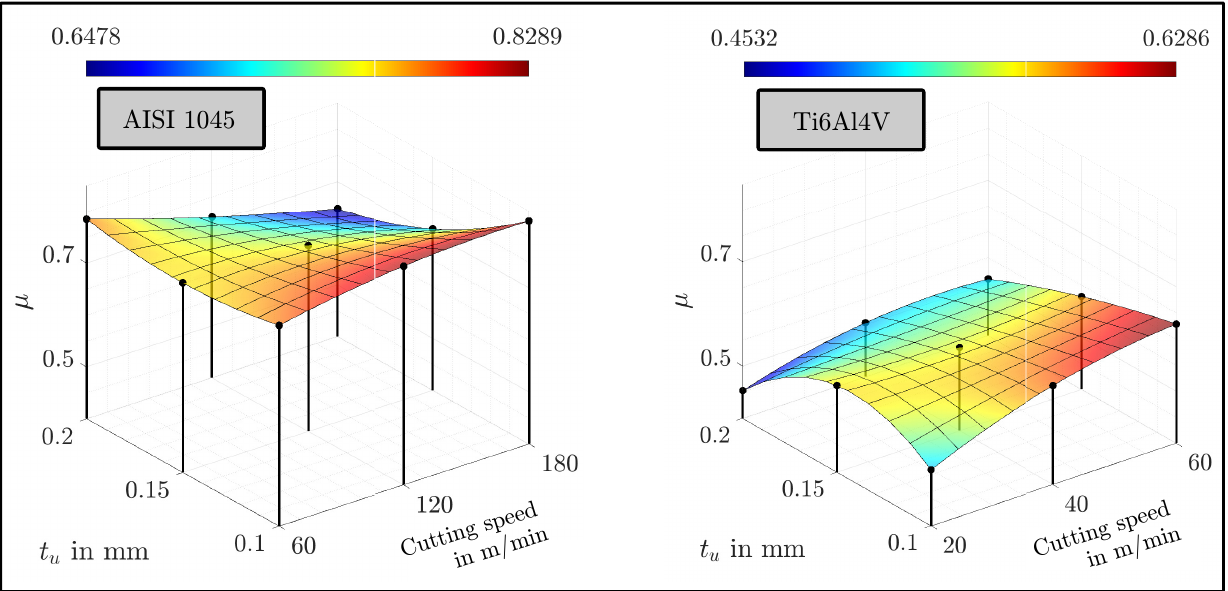
Figure 2. Apparent coefficients of friction as µ = F p / F c calculated directly from the measured forces given in Tables 2 and 3.